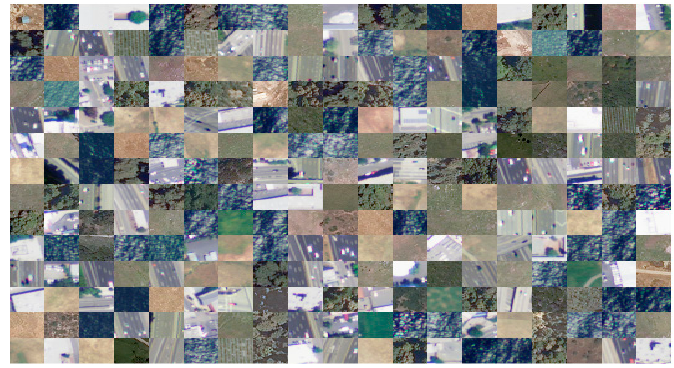
Figure 2. Sample image of Sat 4 and Sat 6 datasets [27,28].